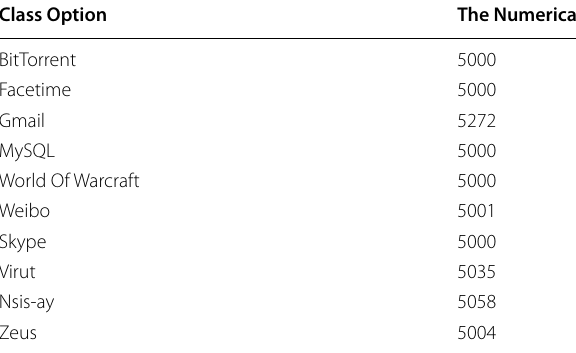
Table 2 The data used In